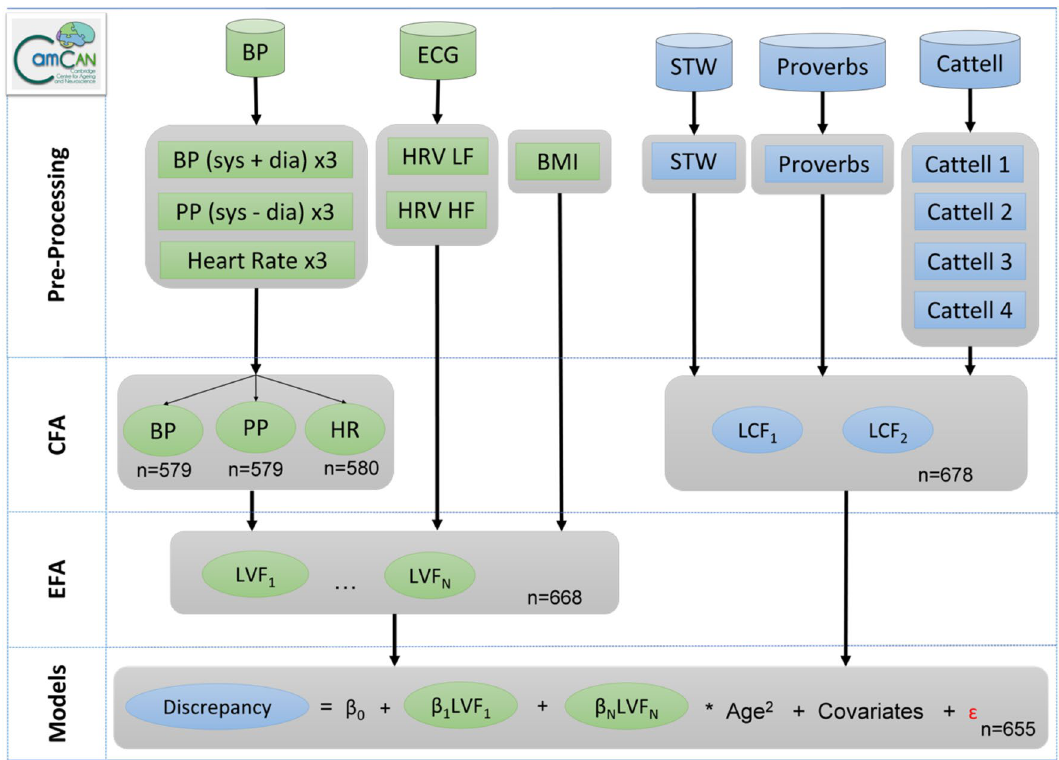
Figure 1. Schematic representation of the data processing and analysis pipeline to investigate shared and unique relationships between vascular and cognitive factors in the Cam-CAN dataset (n = 708). BMI body mass index, BP total blood pressure (systolic + diastolic), dia diastolic, Cattell 1–4 sub-scores across the four Cattell tasks, CFA confirmatory factor analysis, Discrepancy, the ability discrepancy, defined as LCF2 (crystallized) minus LCF1 (fluid), ECG electrocardiogram, EFA exploratory factor analysis, HR heart rate, HRV HF heart rate variability at high frequency, HRV LF heart rate variability at low frequency, LCF latent cognitive factor, LVF latent vascular factor, PP pulse pressure (systolic − diastolic), sys systolic, STW spot the